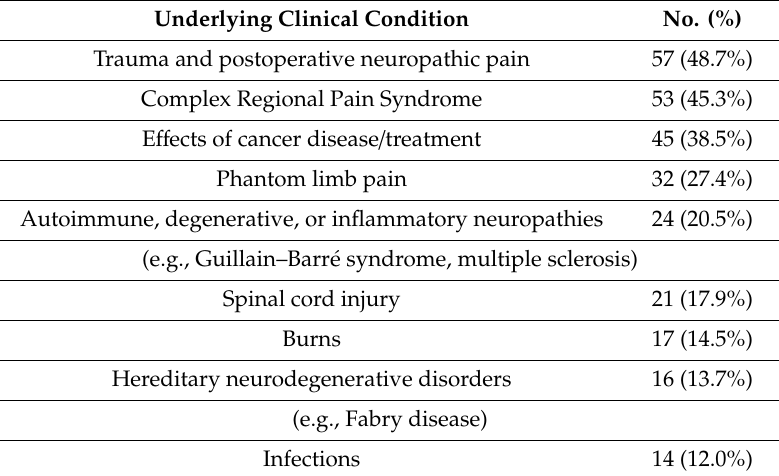
Table 4. Underlying condition for neuropathic / mixed